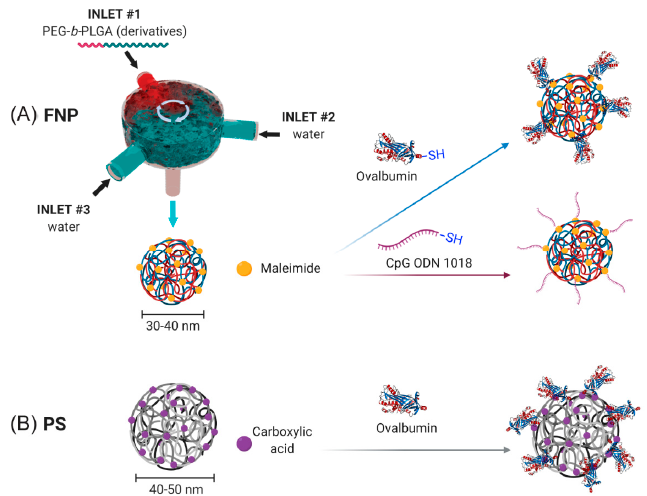
Figure 1. Nanoparticle conjugation schema. ( A ) Conjugation scheme for flash nanoprecipitation (FNP) produced PEG- b -PLGA NPs using maleimide-thiol chemistry for surface conjugation of thiolated ovalbumin (OVA) or CpG oligodeoxynucleotide (ODN) 1018. ( B ) Conjugation scheme for PS NPs using EDC NHS ester chemistry.